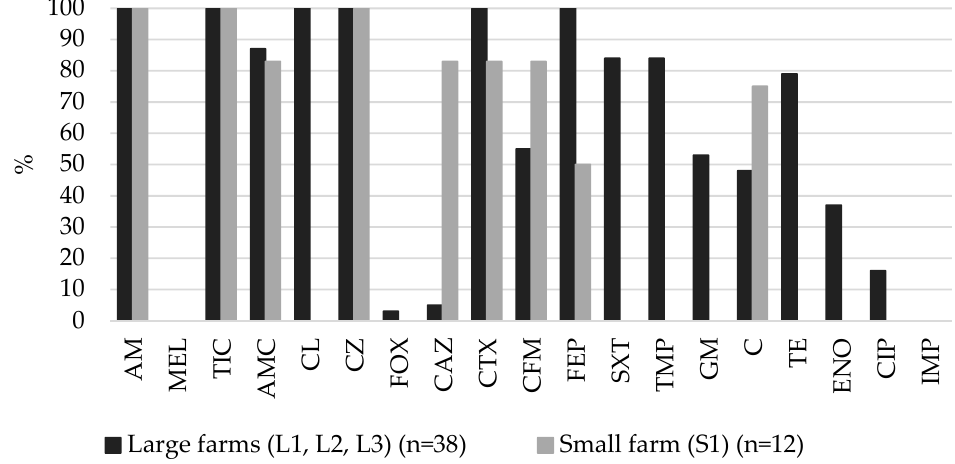
Figure 1. Prevalence of resistance in fecal ESBL-producing E. coli isolates from pigs on large and small farms. AM–ampi-